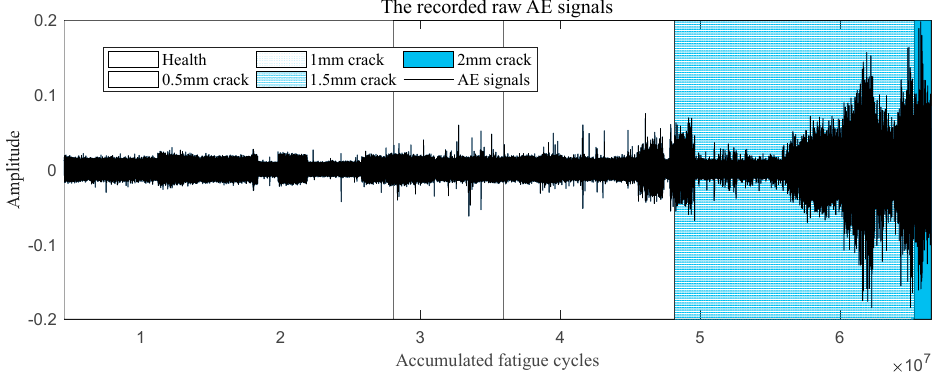
Figure 8. Display the raw AE signals according to the fatigue cycles. To monitor and visualize the development of incipient damage, ultrasonic inspec- tions were performed periodically during the test using the Olympus OMNISCAN SX (Olympus, Tokyo, Japan) phase array ultrasonic tester (PAUT). According to the PAUT inspection results, the health condition of the test specimen was divided into five stages, as indicated by different colors in Figure 8. The number of records for each state is pre- sented in Table 1. The short-time Fourier spectrograms of several randomly chosen AE signals, which are typically observed during the five stages of the damage propagation, are presented in Figure 9. It can be seen that the fault signatures at the early stage of the damage (corresponding to 0.5 mm and 1 mm length of the internal crack) are still invisible to the naked eye. As the faults grow up to 1.5 mm, some high-frequency components in- duced by AE bursts emerge gradually, and the number of AE bursts increases with the damage development. Table 1. The number of AE records for different stages of damage propagation. Health